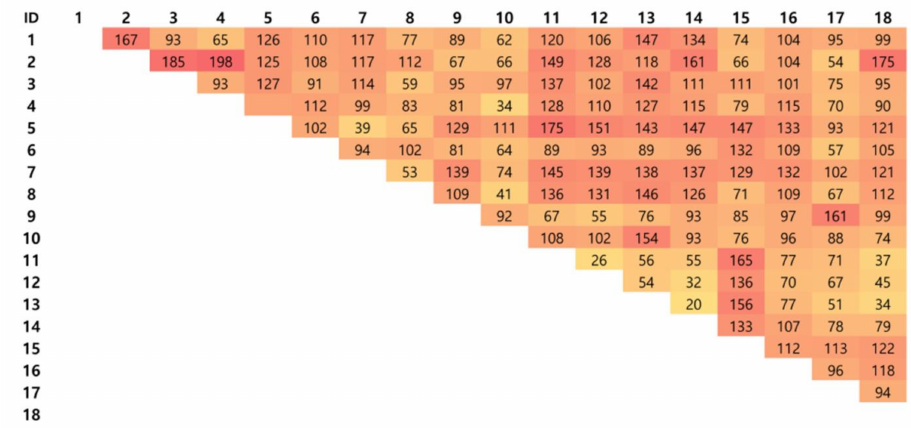
Figure 2. Number of DEGs (Di ff erentially expressed genes). Number of DEGs per tissues identified through pairwise tests of 18 skeletal muscles (min = 20, max = 198), the sample ID is the same as shown in Figure 1.